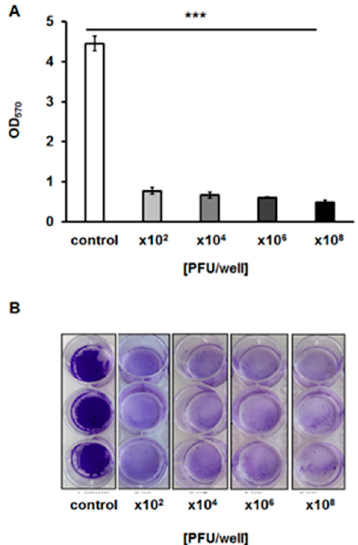
Figure 7. Bacterial biofilm density after a 24-h incubation with vB_EfaS-271 phage lysate added to final titers of 10 2 , 10 4 , 10 6 or 10 8 PFU/well. The results were estimated by measuring the optical density at a wavelength of 600 nm of the resuspended biofilms ( A ) or quantified densitometrically using the Quantity One program ( B ) from bacterial biofilm pictures ( C ). Error bars indicate the SD from triplicate experiments. Statistically significant differences ( p < 0.001 in the t -test) between control and analyzed samples are marked by asterisks (***).